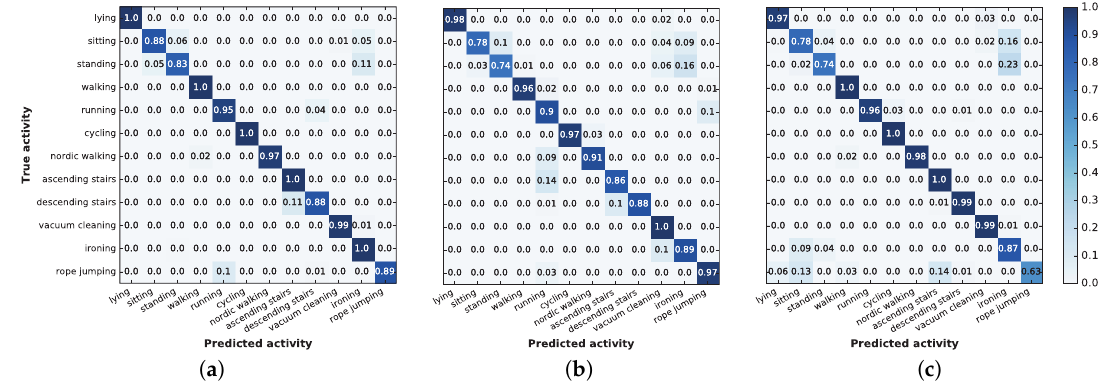
Figure 9. Confusion matrices for the 12 activities aggregated for all subjects, for the high-performing classifiers. ( a ) Extra trees; ( b ) DNN 1L; ( c ) LDA.